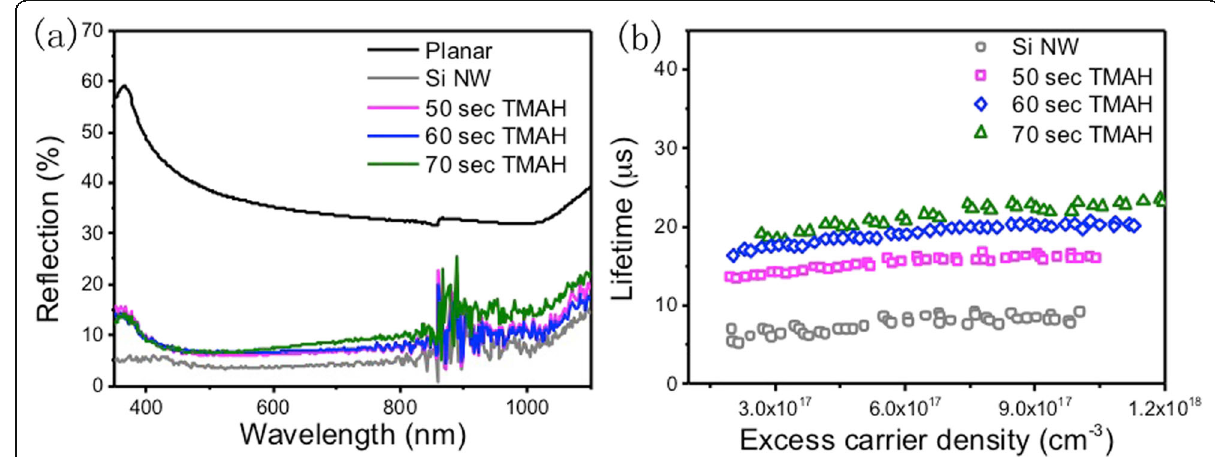
Fig. 2 Reflection and minority carrier lifetime characterization of different Si nanostructure. a Reflection spectra of various samples: planar Si substrate, Si NW without and with different TMAH time. b Injection depended minority carrier lifetime of different